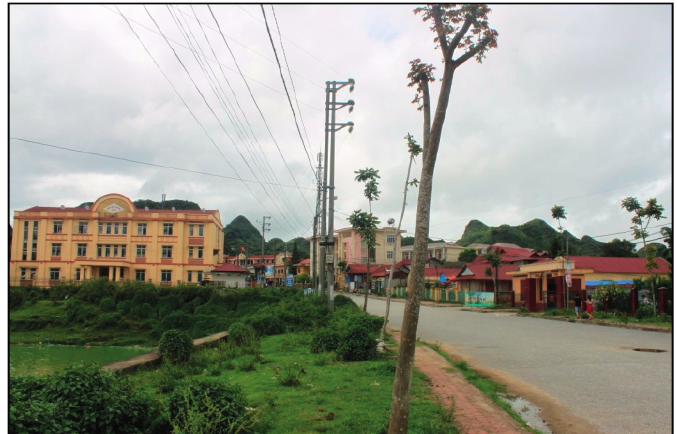
Figure 6. Sìn H ồ Town on Road 12. (Photo credit: Lê M ạ nh